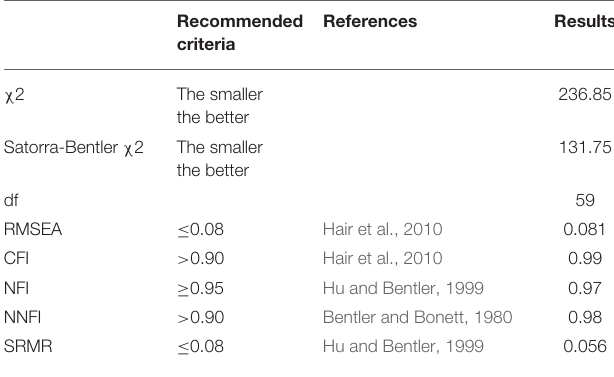
TABLE 1 | Model fit criteria summary table of the storytelling in agricultural marketing effectiveness